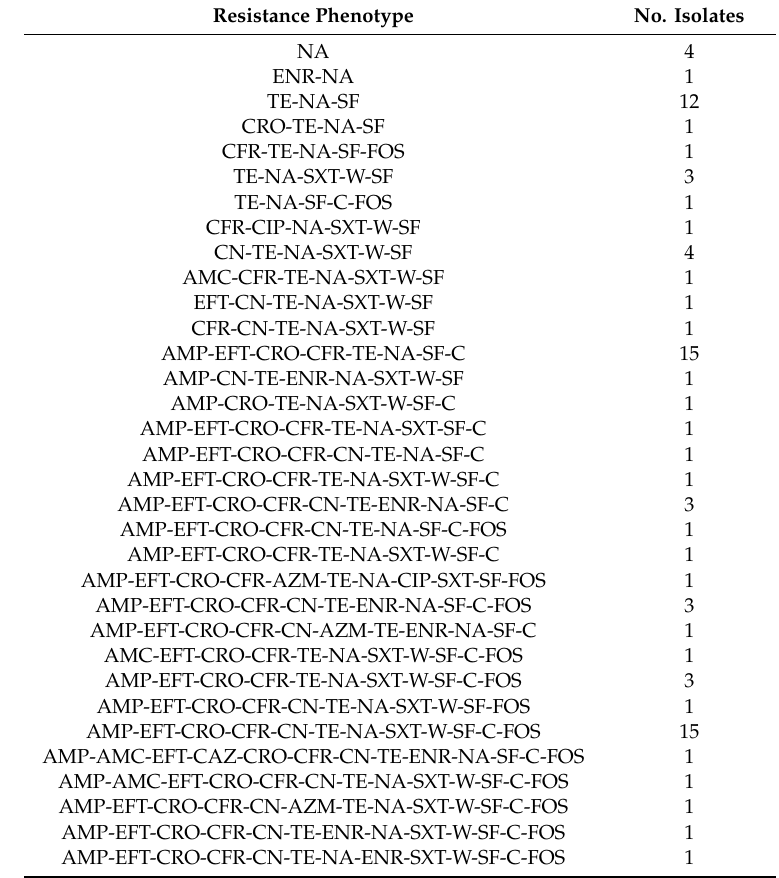
Table 2. Phenotypic resistance profiles detected in Salmonella Infantis